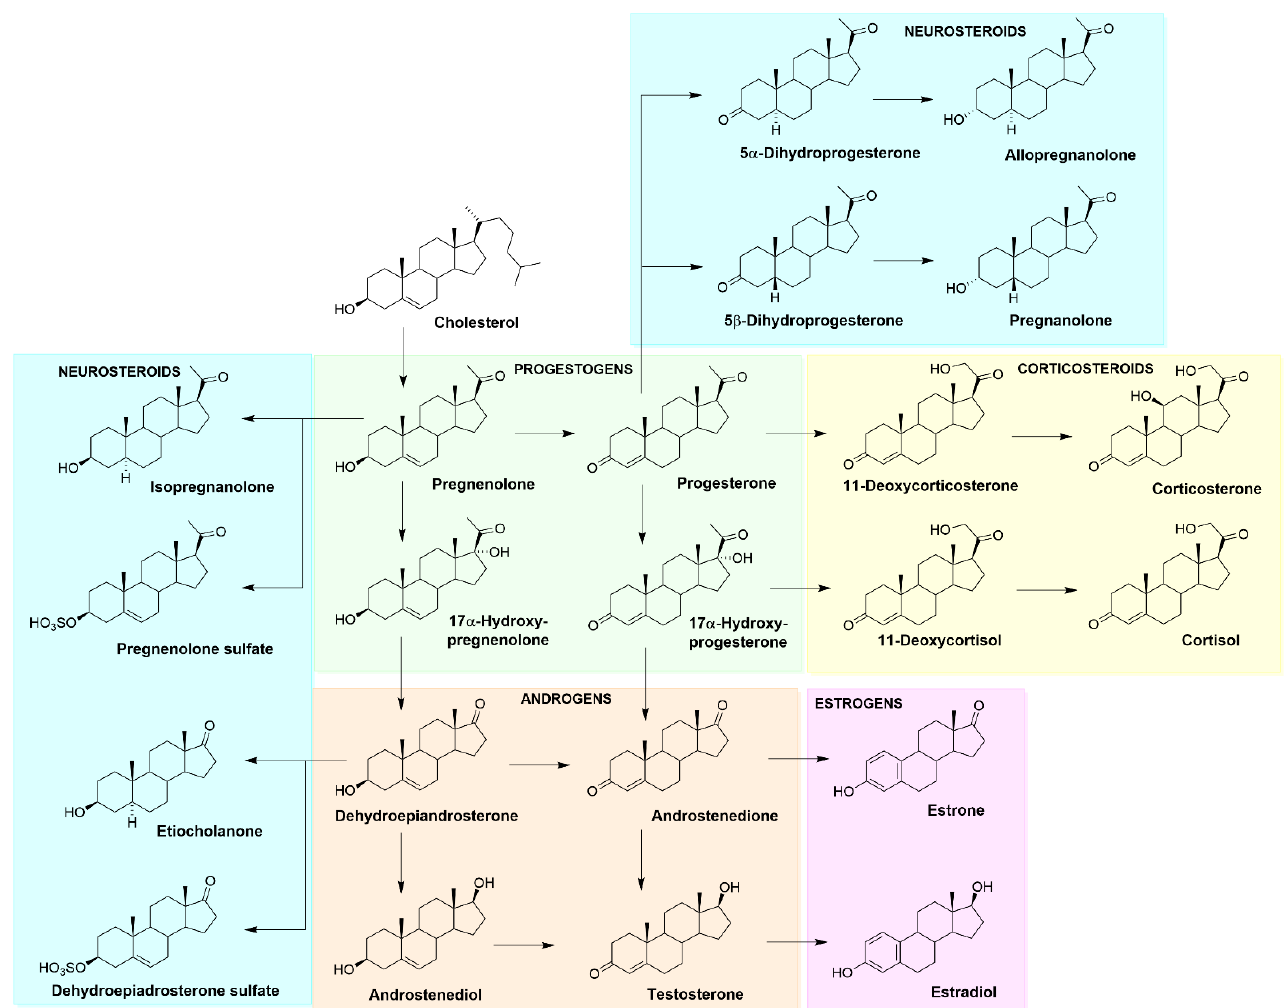
Figure 3. Simplified scheme of steroid biosynthesis, including the major classes of steroid hormones and examples of neurosteroids.